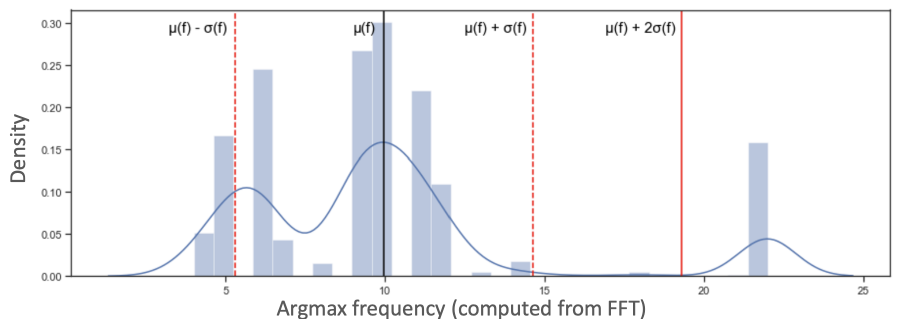
Figure 6. A histogram of values of the representative frequency (computed from FFT, see text) for windows of size 128, in the training data of the respiration belt, DEAP